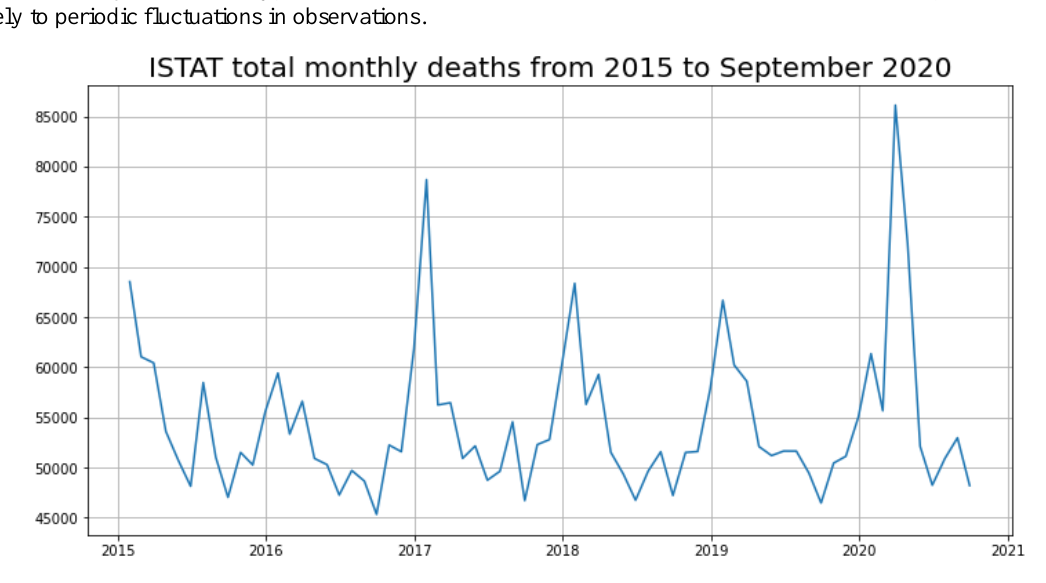
Figure 9. Monthly trend of total Italian’s